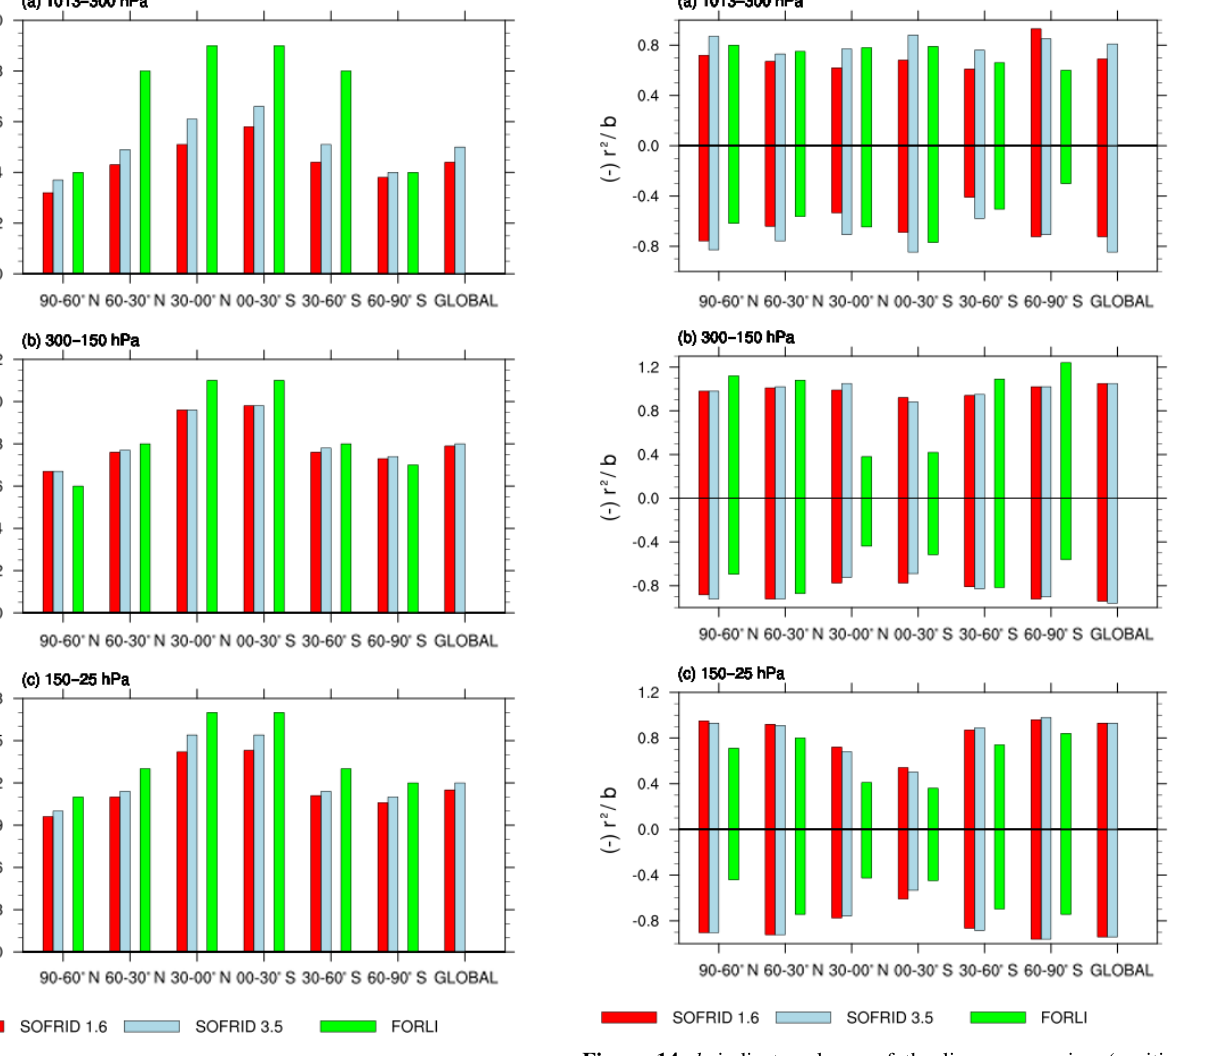
Figure 13. DFS of IASI SOFRID-O3 v1.6 (red), SOFRID-O3 v3.5 (light blue) and FORLI-O3 (green) retrievals in the different latitude bands for (a) 1013–300hPa, (b) 300–150hPa and (c) 150–25hPa. FORLI data are taken from Boynard et al. (2018).